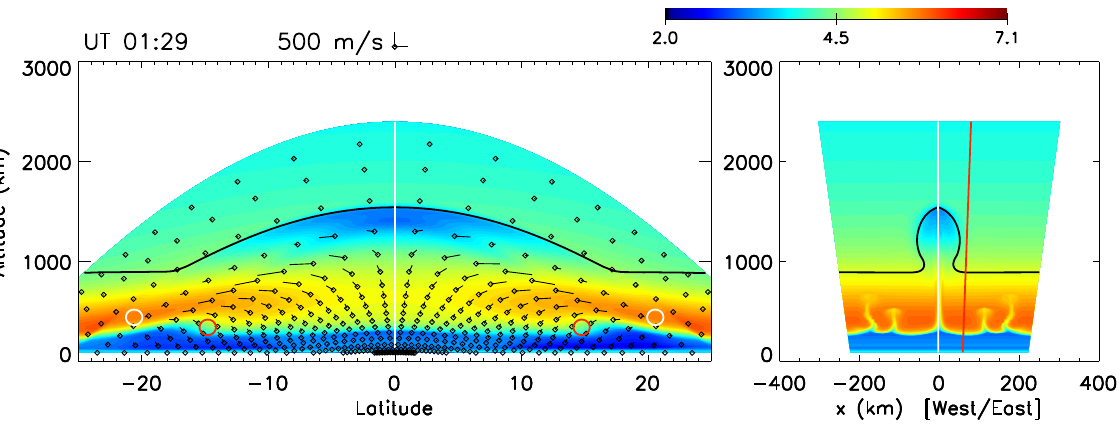
Fig. 1. Contours of log 10 n e at a fixed longitude (left) and at the magnetic equator (right). The location of the left-hand contour in the right-hand panel is indicated by a white line and vice versa. Ionization crests are indicated within the ESF plume (white circles) and in the background (red circles). A dark curve near the center of each plot indicates the H + /O + transition height. In the left hand panel, O + ion velocity vectors indicate the direction of flow away from the